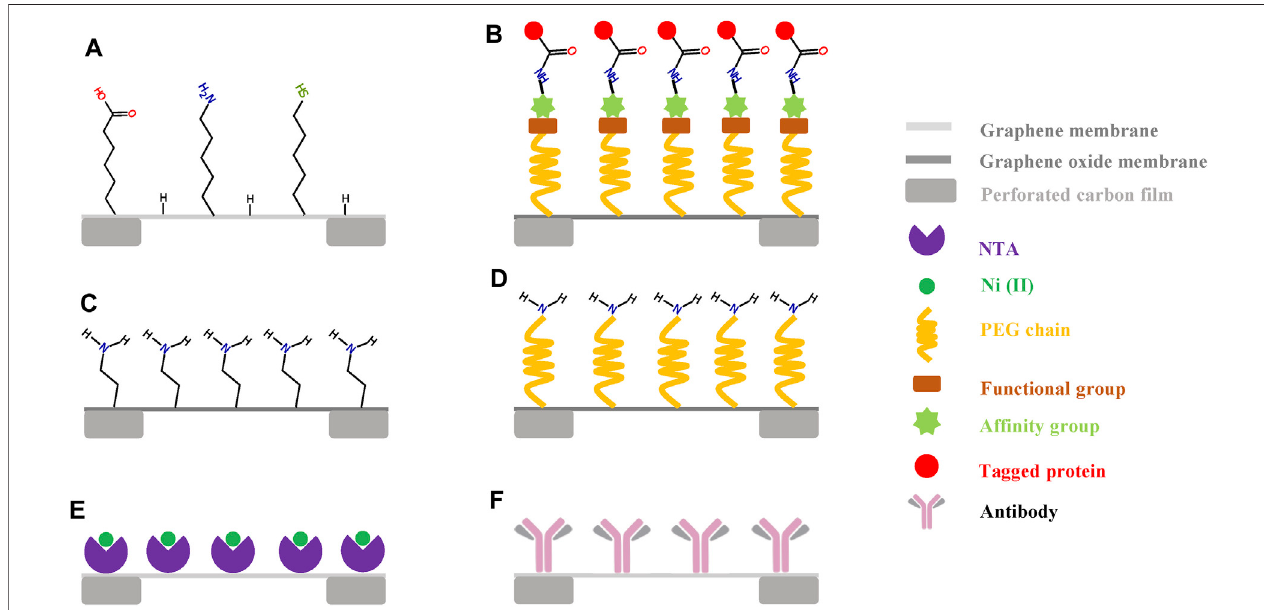
FIGURE 2 | Functionalization of graphene grids. (A) the graphene fi lm can be covalently functionalized with different organic molecules in a low-energy helium plasma (Naydenova et al., 2019). (B) the chemically functionalized graphene oxide (GO) grid has a special and general af fi nity for biomolecules fused with either SpyCatcher or SpyTag (Wang et al., 2019). (C,D) GO grid functionalized with amino groups or PEG-amino groups (Wang et al., 2020b). (E) the bioactive graphene grid can selectively capture His-tagged samples with the introduction of Ni – N α ,N α -dicarboxymethyllysine groups onto the graphene surface (Liu et al., 2019). (F) the antibody-coated grid has a high and speci fi c af fi nity for the target protein samples (Yu et al.,